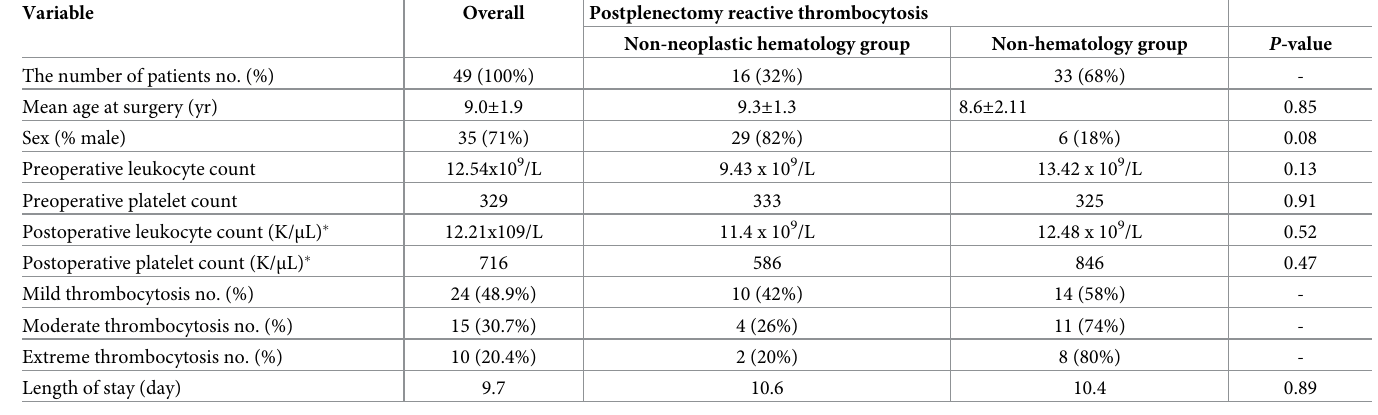
(Table 1). None of the patients developed thrombotic or hemorrhagic complications during the follow-up period. Neither postoperative death nor subsequent fatal infections were observed in the cohort. Forty-nine patients (94.2%) developed a postplenectomy RT. The per- centages of mild, moderate and extreme thrombocytosis were 48.9%, 30.7%, and 20.4%, respectively. The comparisons between RT patients in non-neoplastic hematology and non- hematology groups is shown in Table 2. In the non-neoplastic hematology group of patients, a gradual increase in platelet count was observed from the first to sixth day after splenectomy. group of patients, the platelet count decreased in the first two days after splenectomy, probably because of hemodilution but gradually increases starting at day three. From the sixth to the the platelet count, but RT persisted three weeks following splenectomy (Table 3). Although the pared with the non-neoplastic hematological group, the difference was not significant Table 2. The comparative analysis of various clinical parameters between the two groups of the patients affected by reactive thrombocytosis.